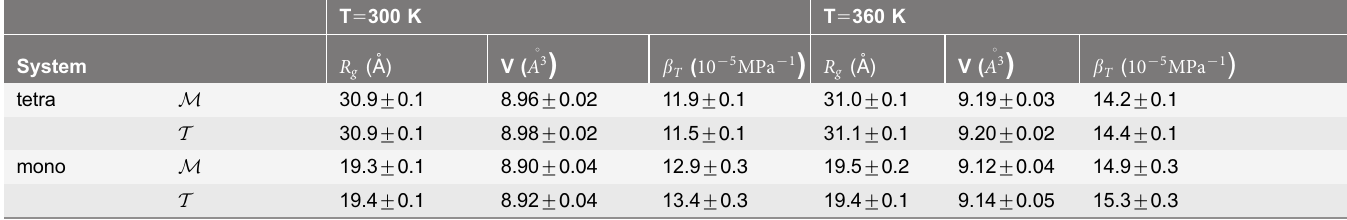
Table 1. Radius of gyration, volume and intrinsic compressibility.